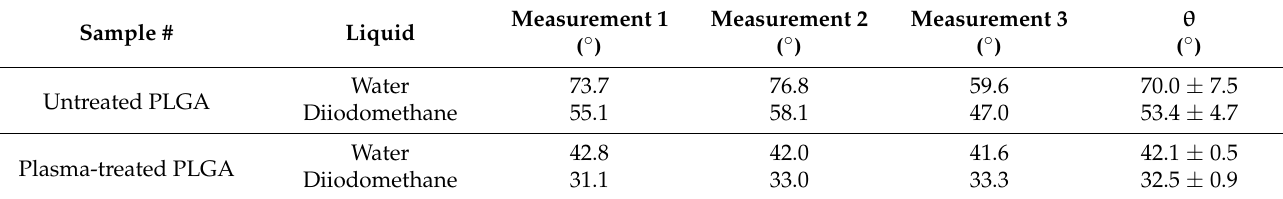
Table 3. Contact angle measurements of the solvent-cast PLGA